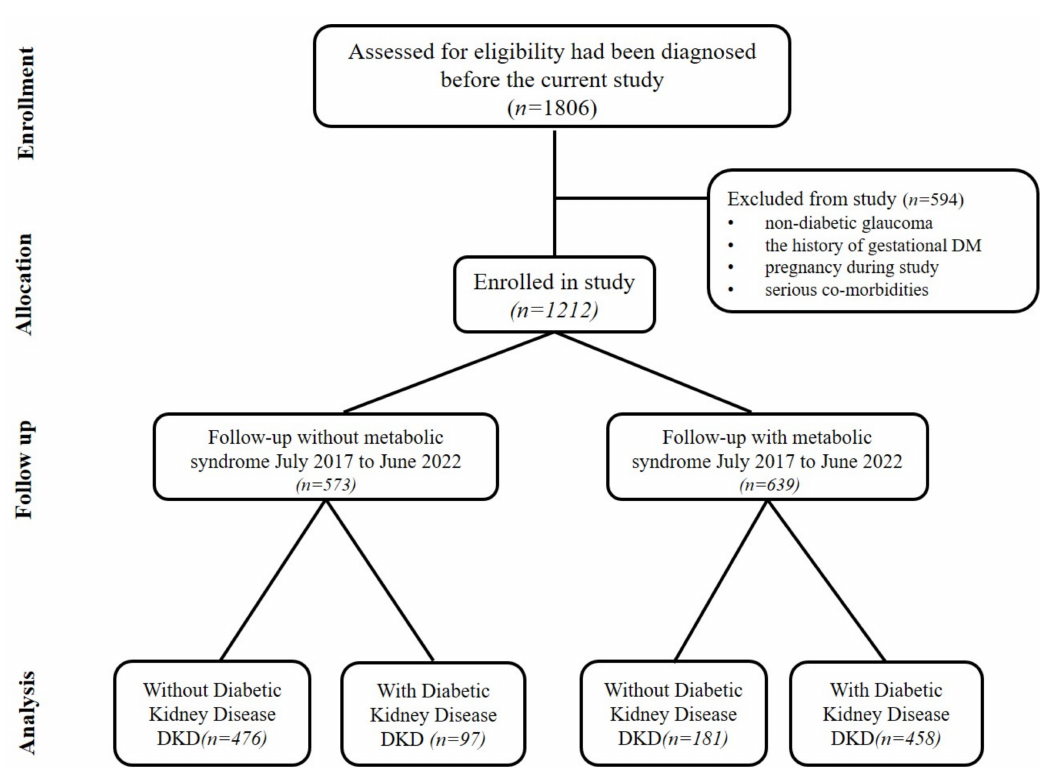
Figure 1. Flow diagram for the case-control study of T2DM patients in